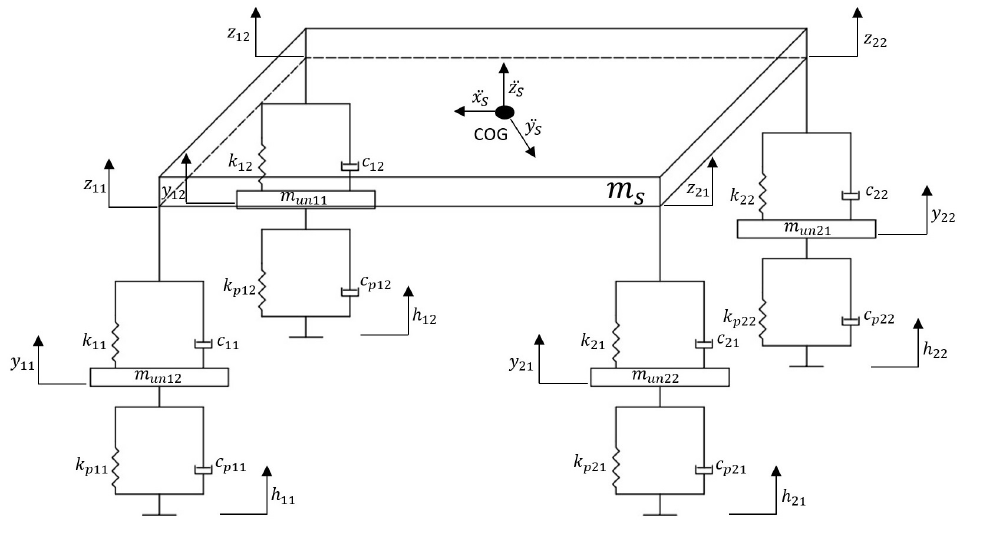
Figure 8. 7-DOF mathematical